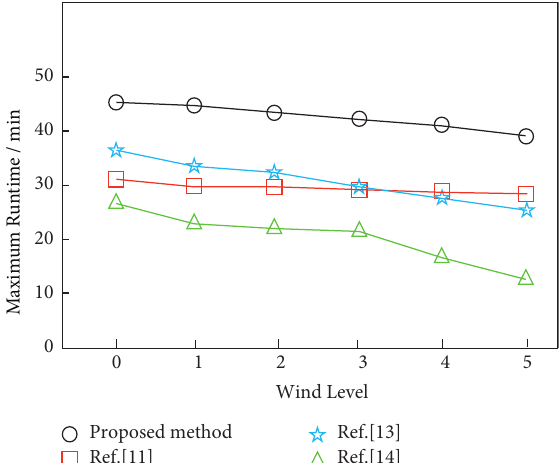
Figure 9: The relationship between the maximum runtime of different robots and the wind level.